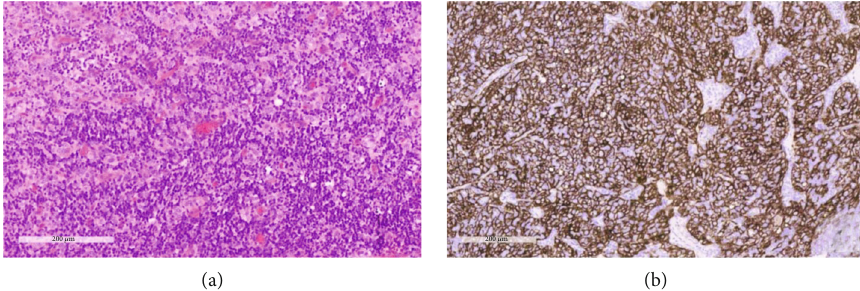
Figure 3: (a) High-magni fi cation image showing a biphasic neoplasm composed of lymphocytes and epithelial cells. (b) Immunostaining for high molecular weight cytokeratin (CK5/6) highlighting the epithelial component. The lymphocytes are